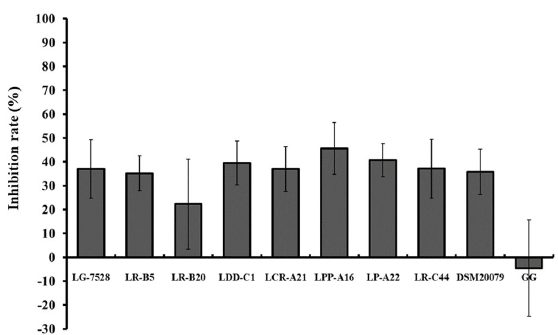
Figure 7. Effect of the presence of different lactobacilli strains on Caco-2 invasion by L. monocytogenes EGDe in a displacement assay, where the Caco-2 cells were pre-incubated with L. monocytogenes EGDe for 1 h before the addition of lactobacilli. Data represent the mean values ± standard error of the mean (SEM) of three biological and two technical replicates.